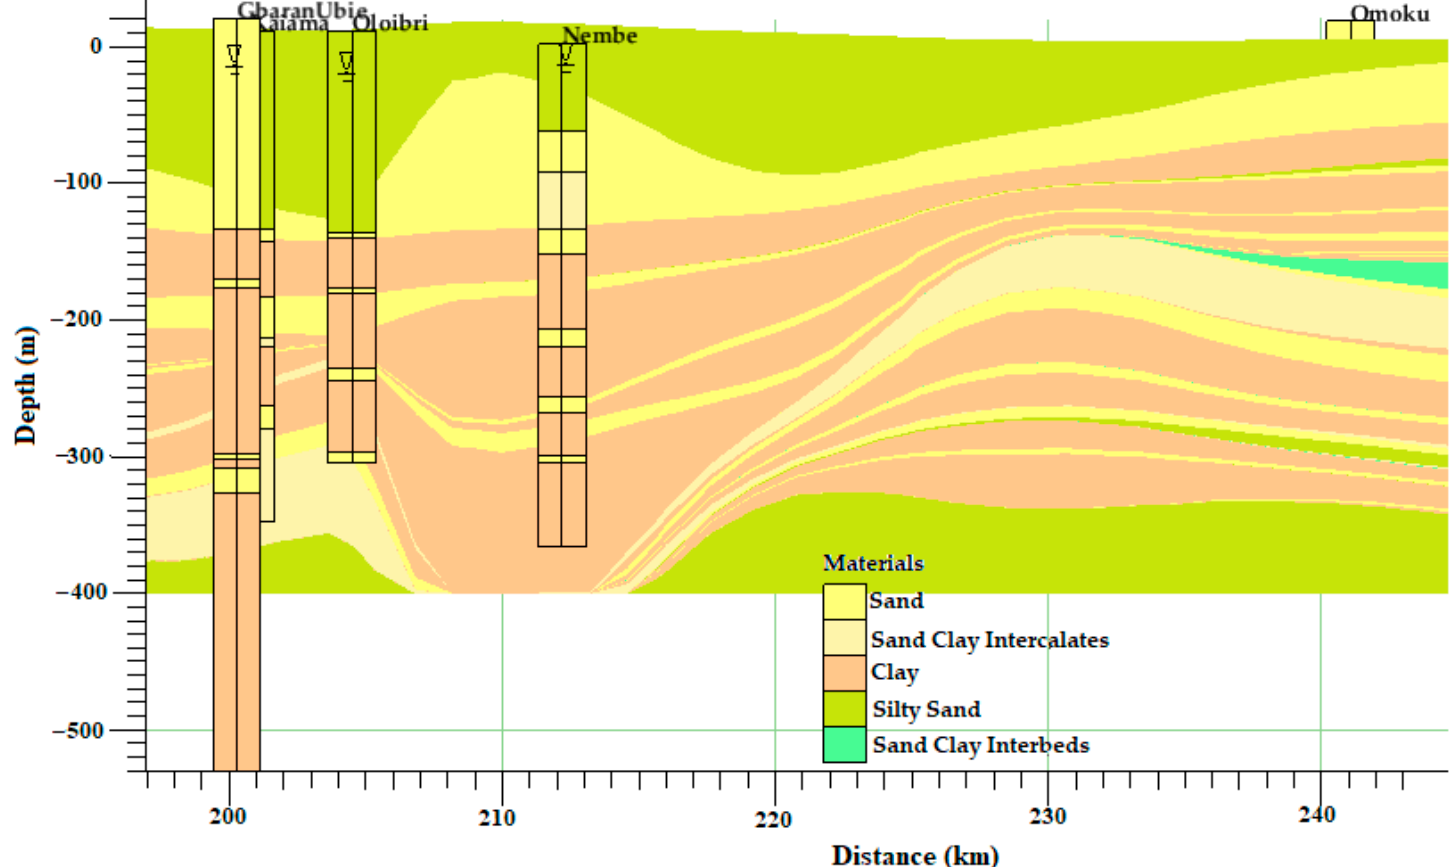
Figure 5. Hydrostratigraphic section along profile line CC I at various zones within the Niger Delta basin.